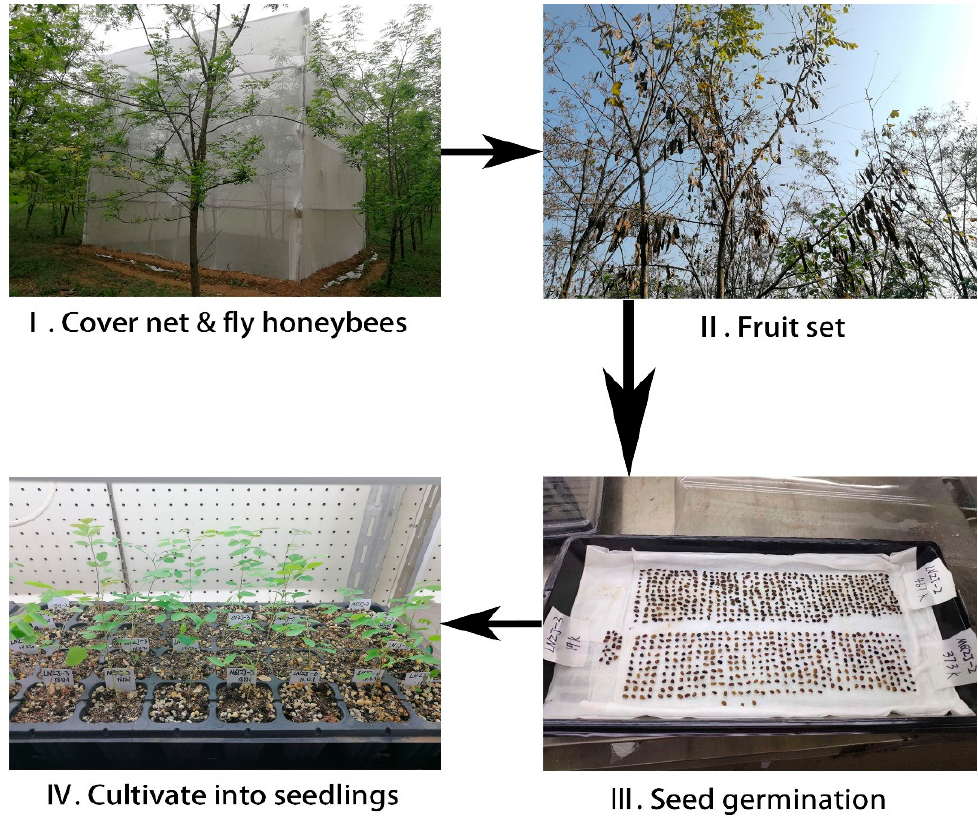
Figure 12. Process of introduction of honeybees to conduct controlled pollination.